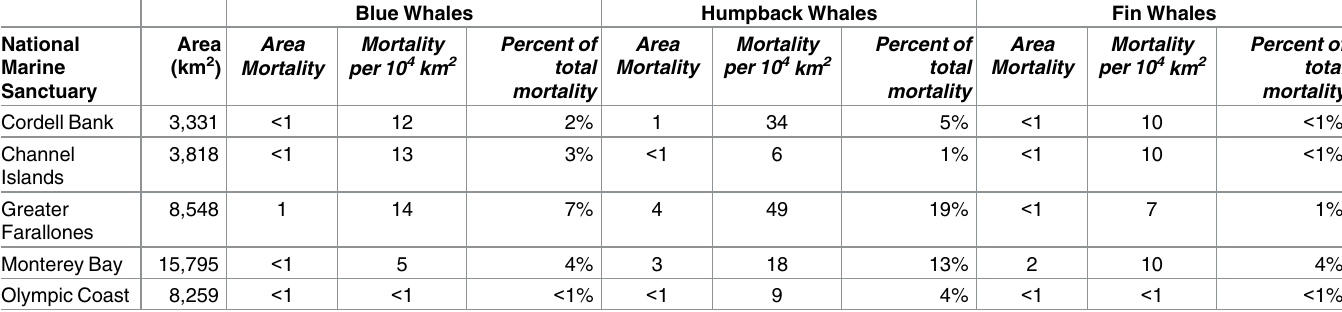
Table 7. Mortality within National Marine Sanctuaries. Mortality per 100,000km 2 and percent of total study area mortality are also reportedfor each sanctuary.